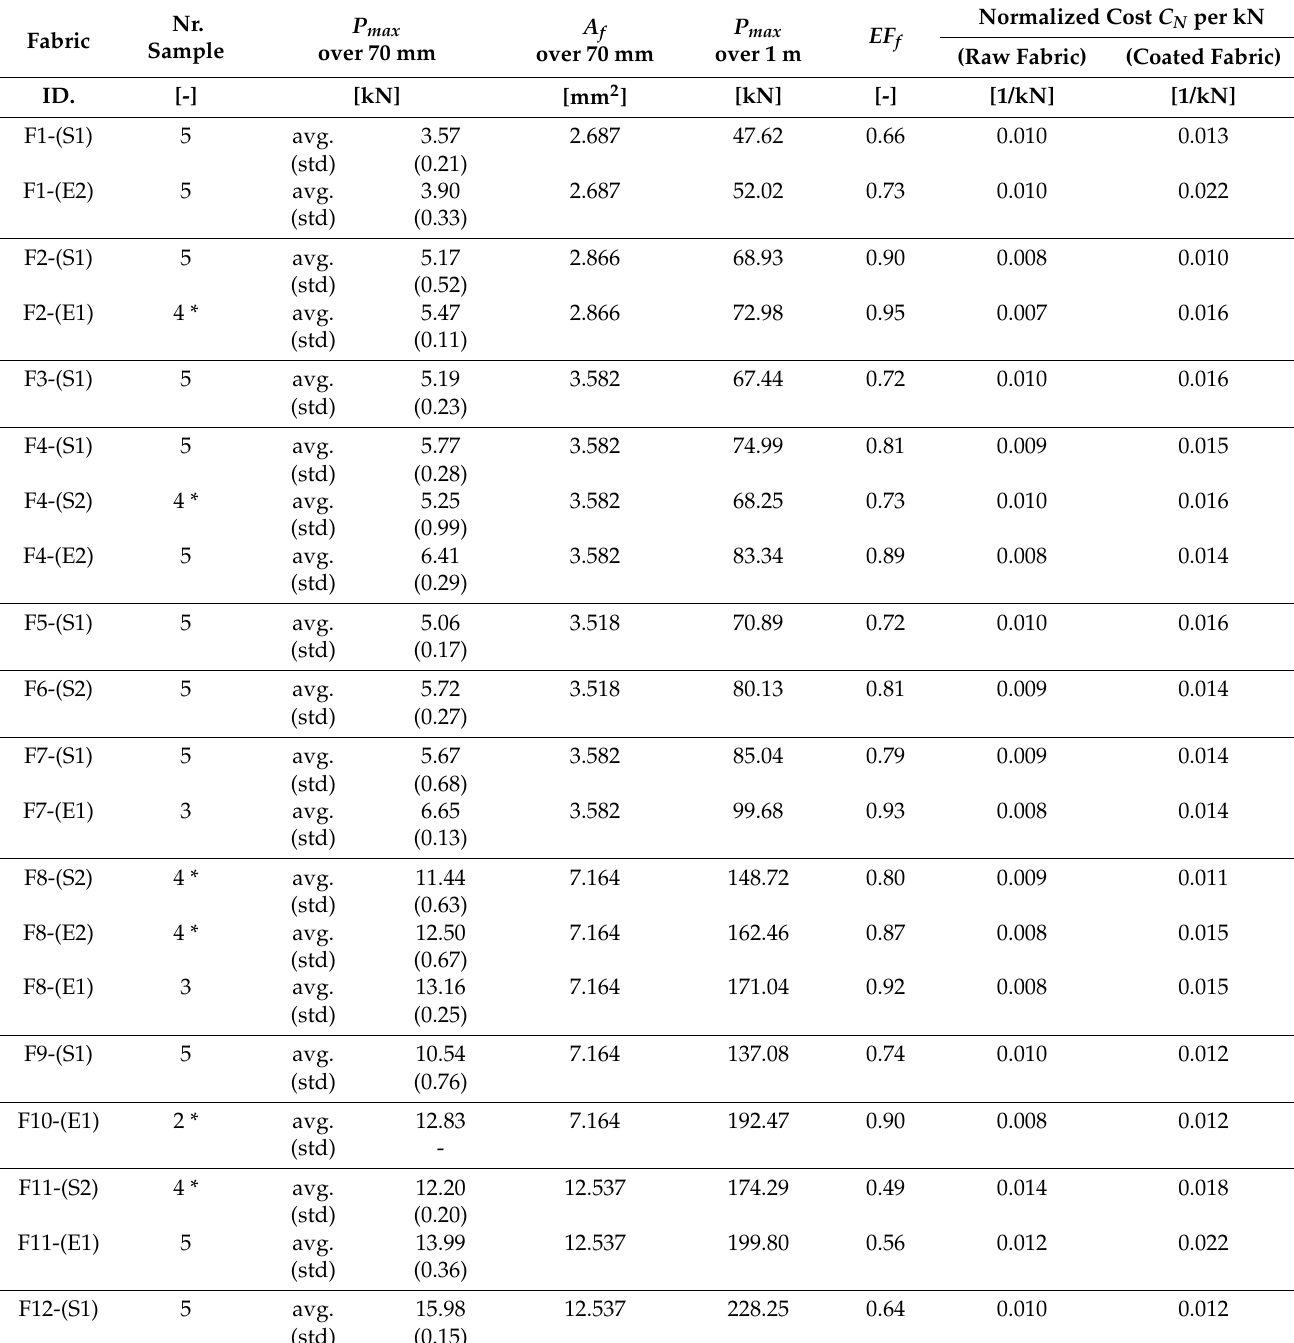
Table 3. Tensile test results in the warp direction and normalized cost per kN of the AR-glass textiles. Fabric